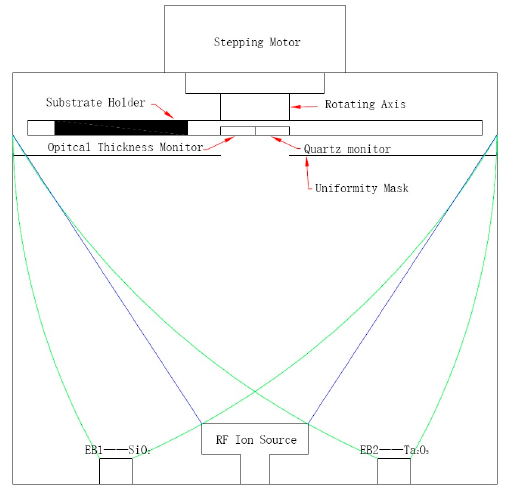
Figure 1. Schema of deposition system.